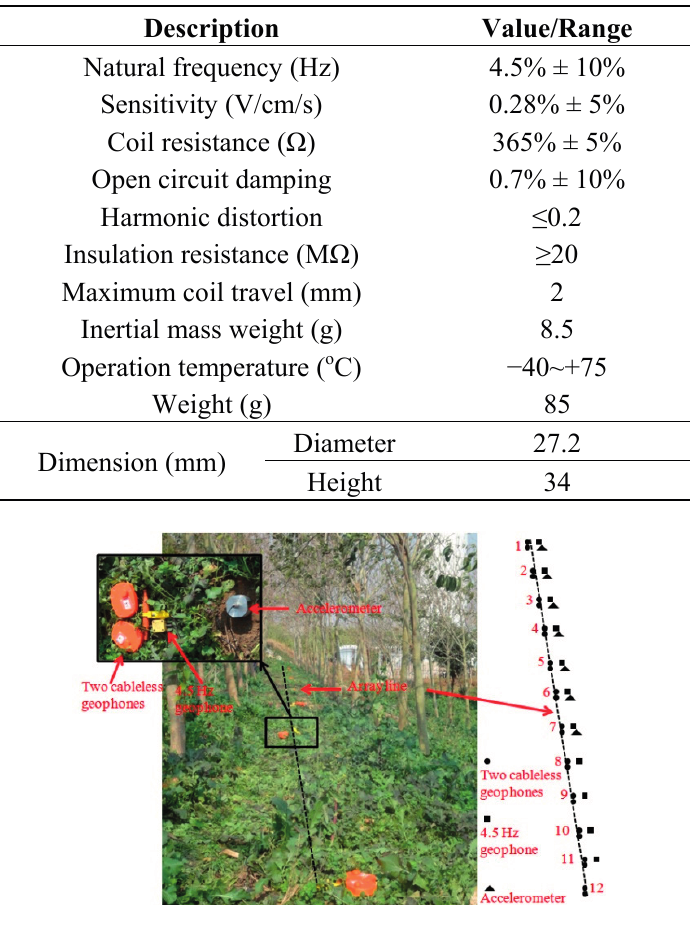
Figure 7. Receiver deployment for the wind farm field